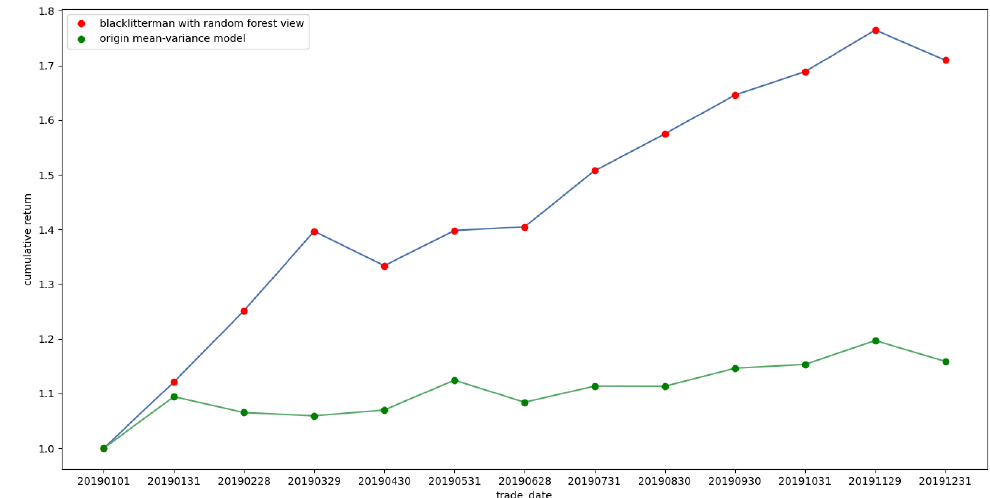
Figure 7. Comparison between the proposed model and MV model on cumulative